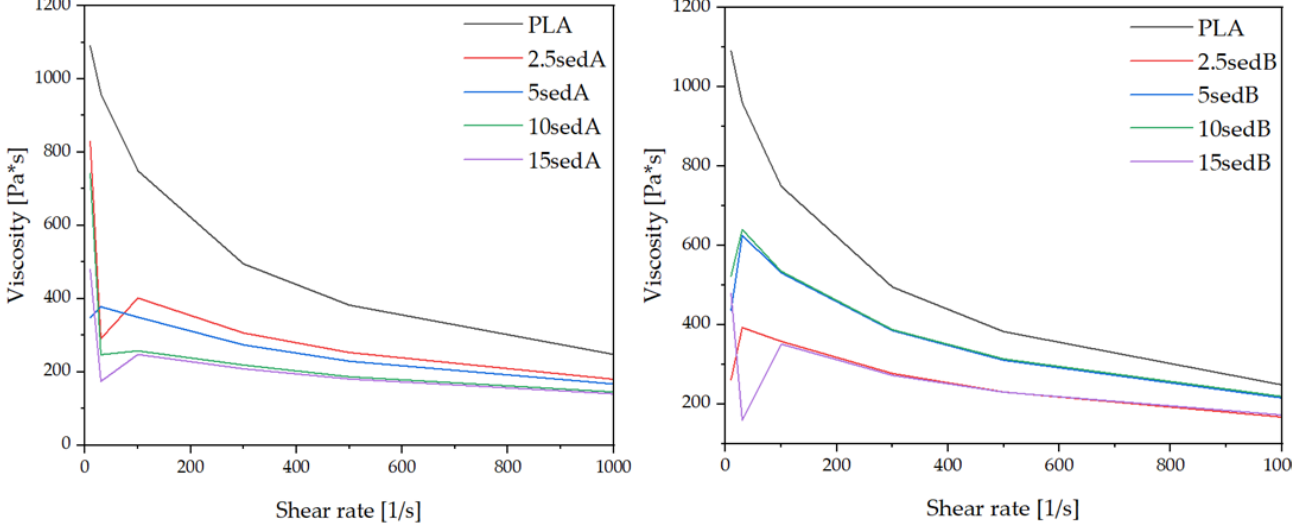
Figure 6. Viscosity of PLA/CLS composites after injection moulding.